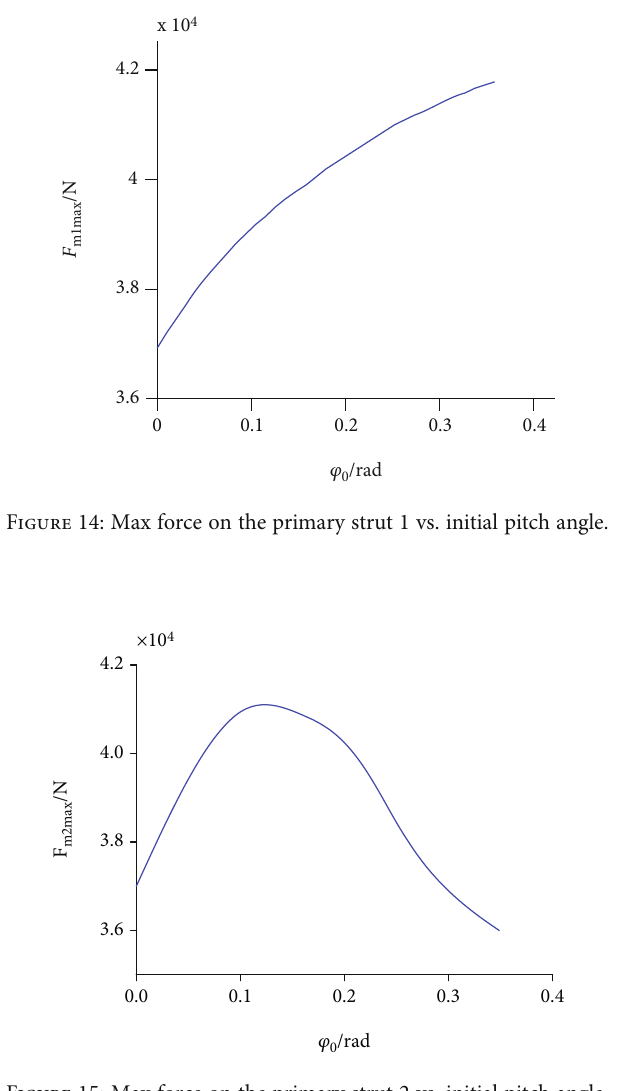
Figure 15: Max force on the primary strut 2 vs. initial pitch